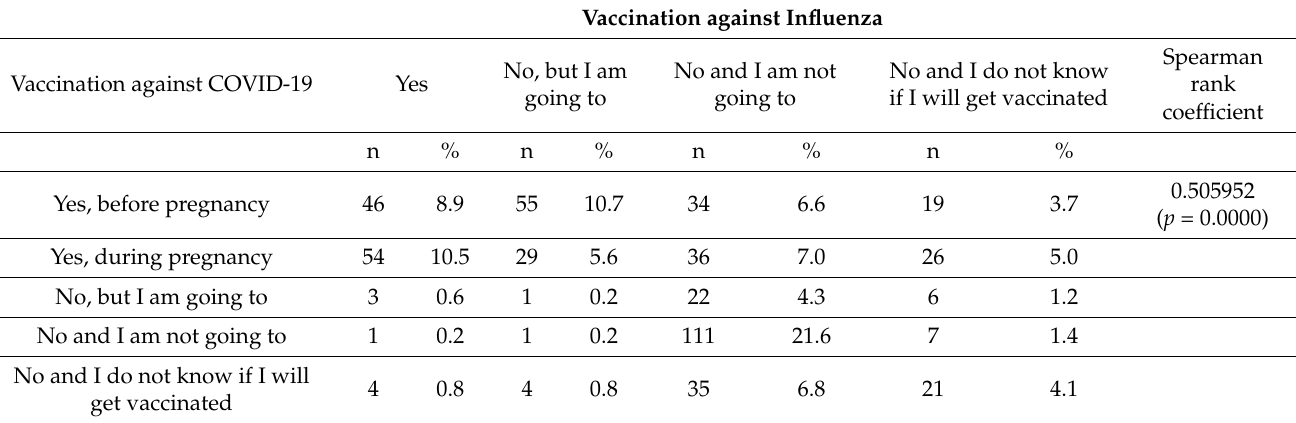
Table 11. Association between COVID-19 and influenza vaccine uptake during pregnancy. Vaccination against